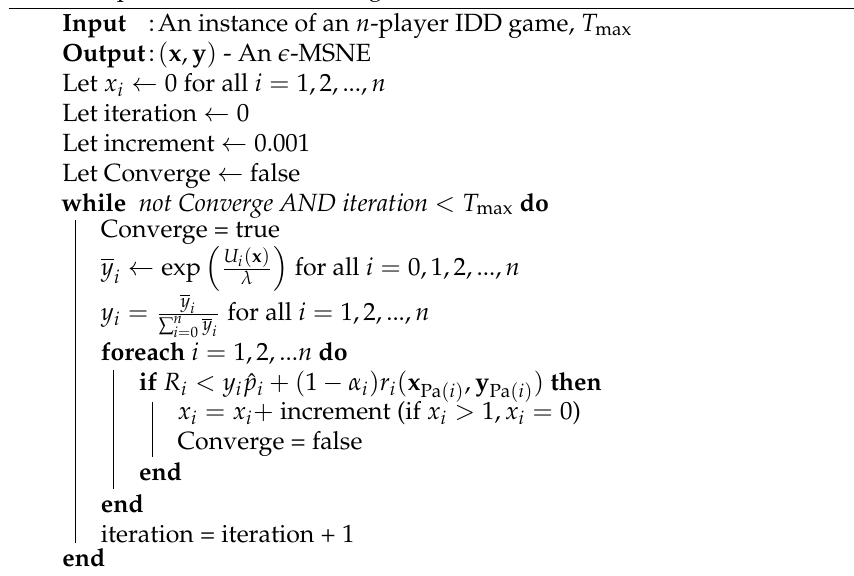
Algorithm 1: Heuristic Based on Hybrid of BRGD and Smooth Best-Response Dynamics (SBRD)